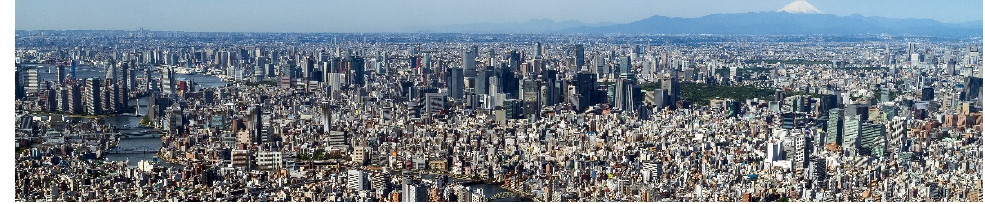
Figure 2. An aerial view of Tokyo (https://commons.wikimedia.org/wiki/File:Tokyo_from_the_top_of_the_SkyTree_(cropped).JPG, author: Yodalica, under CC BY-SA 4.0, accessed on 11 March 2022).